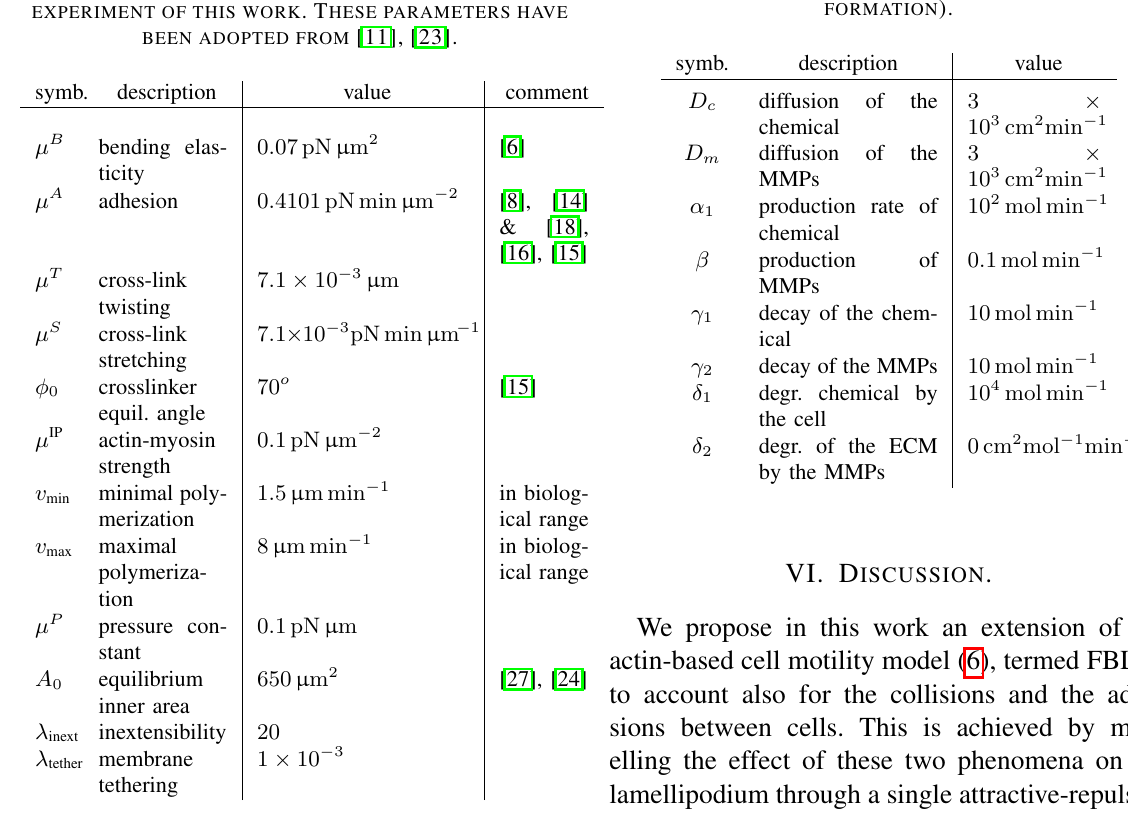
P ARAMETER SETS USED FOR THE SIMULATION OF THE ENVIRONMENT (17) IN THE E XPERIMENT 3 (C LUSTER FORMATION